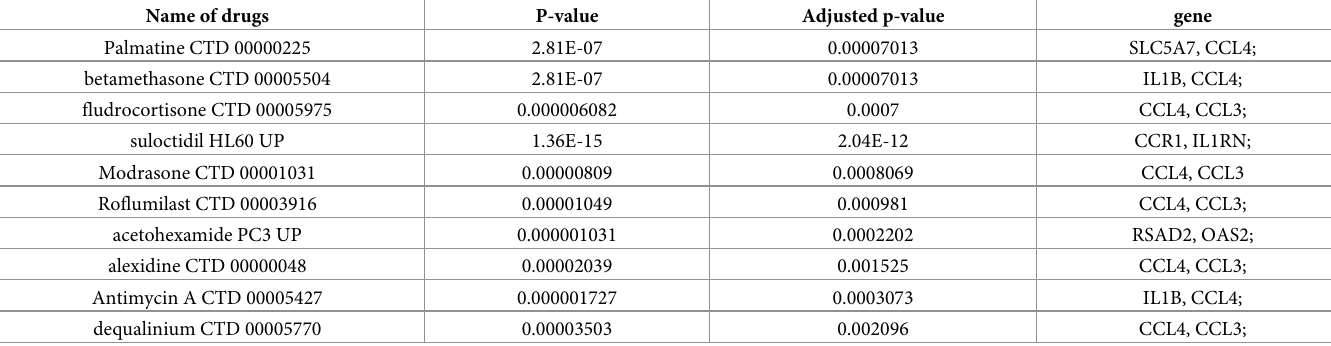
Table 6. List of the suggested drugs for DOWN-DEGs of HCC with